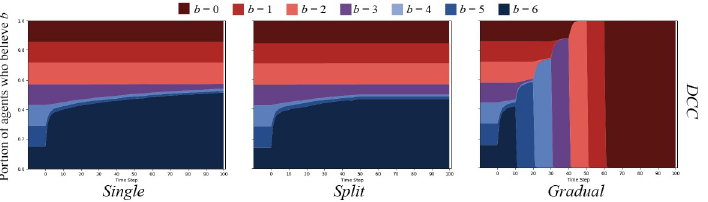
Fig 8. DCC results on WS small world networks. DCC on Watts-Strogatz small world networks with N = 500, initial neighbors k = 5, and rewiring chance ρ = 0.5. Graphs show the percent of agents who believe B with strength b over